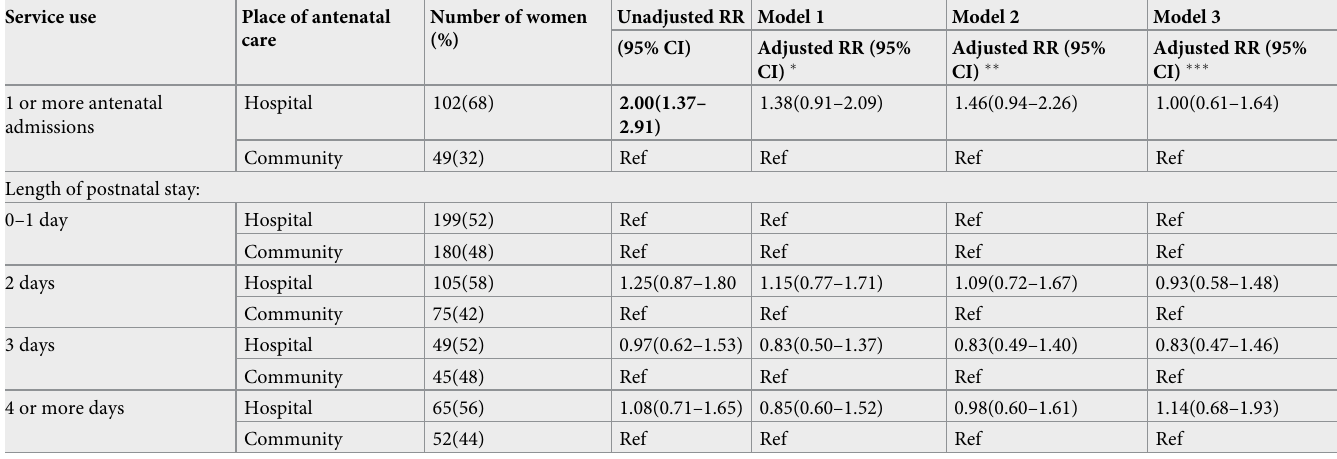
Table 15. Women’s service use in relation to place of antenatal care.